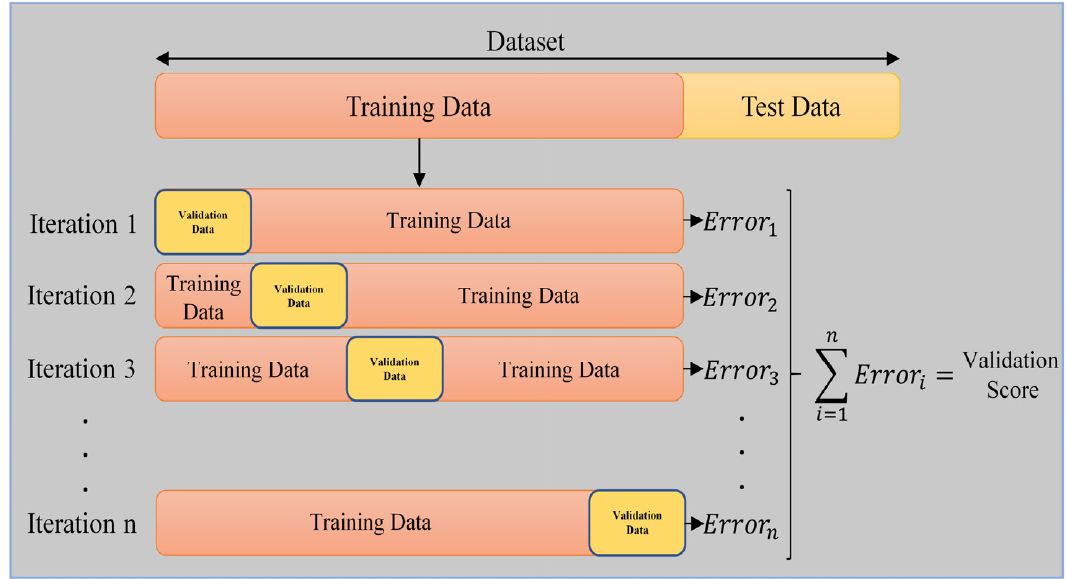
Figure 7. The K-Fold Cross-Validation process.